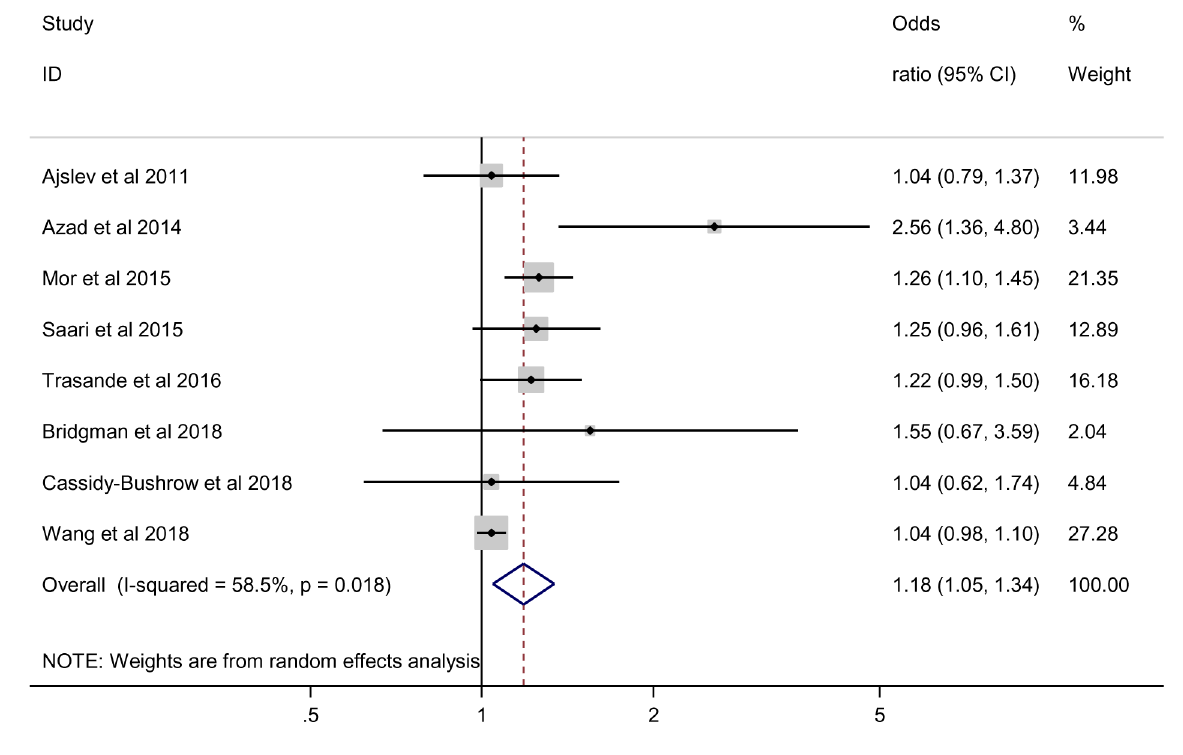
Figure 2. Overweight outcome.